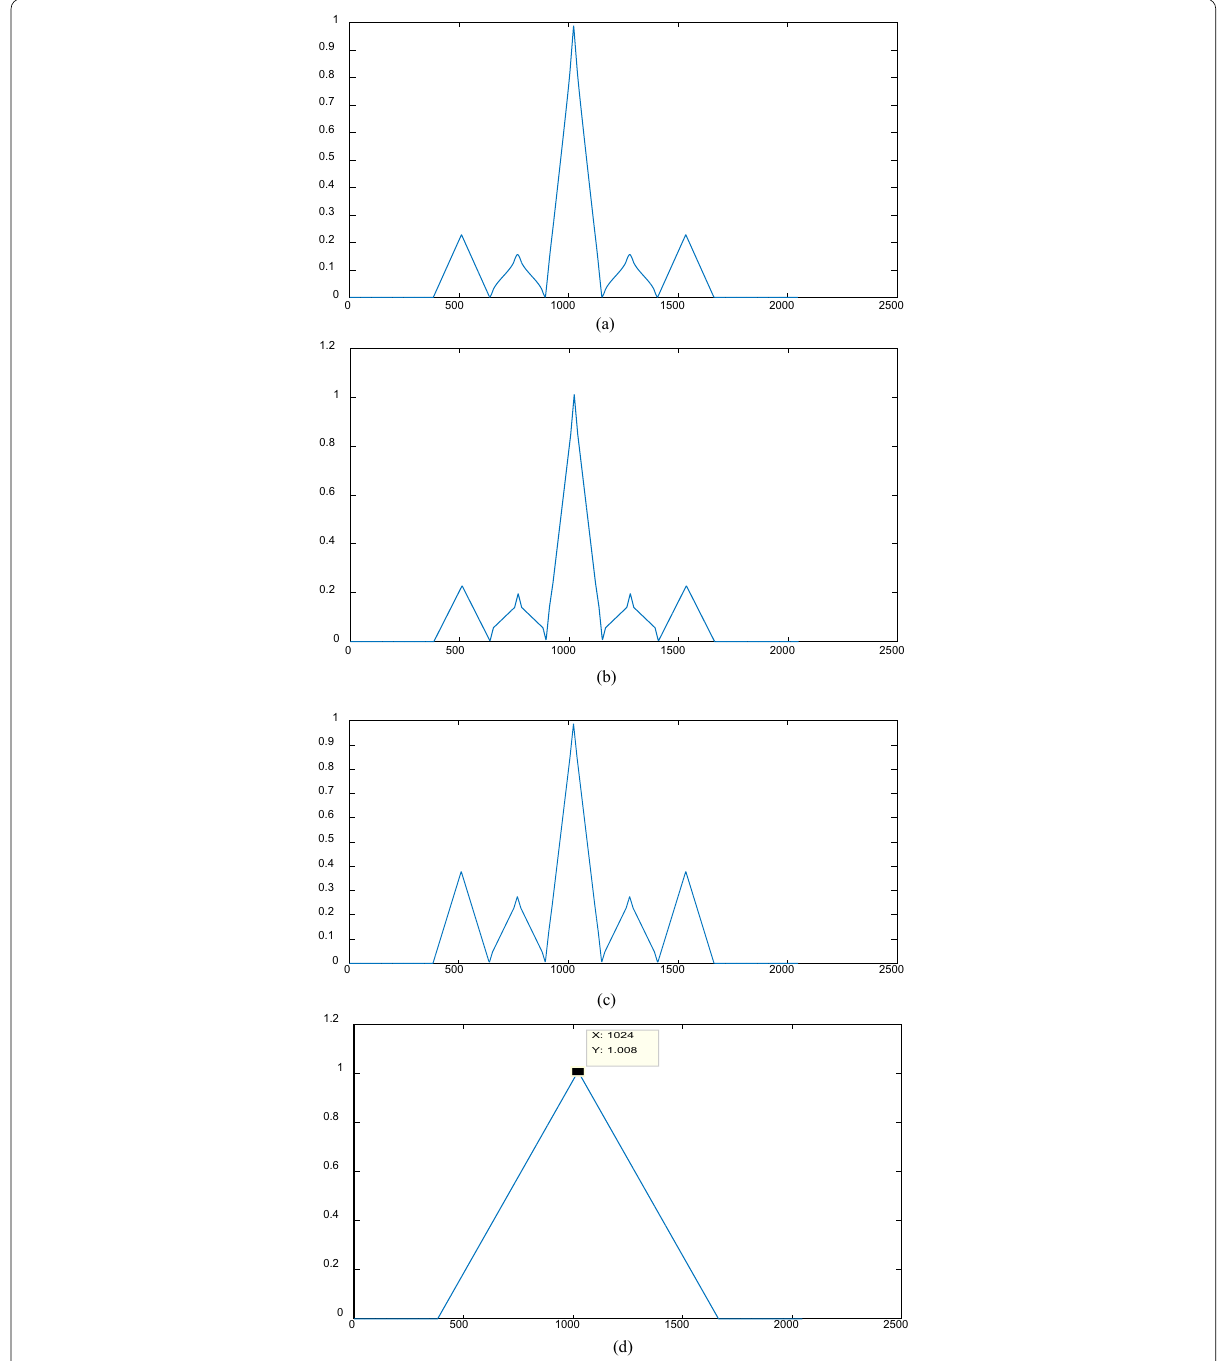
Fig. 6 a The autocorrelation of the aperture shown in the Fig. 1a, where the total band width 640 pixels. b The autocorrelation of the aperture shown in the Fig. 1b, where the total band width width 640 pixels. c The autocorrelation of the aperture shown in the Fig. 1c, where the total band width aperture width 640 pixels. d The autocorrelation of the aperture shown in the Fig. 1d, where the total band width the aperture width 640